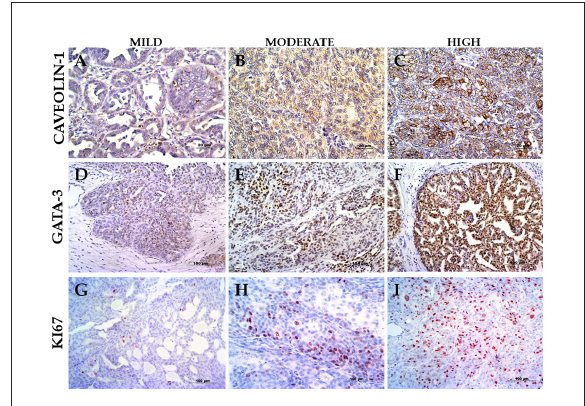
FIGURE1 Immunostaining panel. (A) UC papillary and infiltrating with mild Caveolin-1 (case 6), 400 × magnification. (B) UC papillary and infiltrating with intermediate Caveolin-1 (case 30), 400 × magnification. (C) UC papillary and infiltrating with high Caveolin-1 (case 7), 400 × magnification. (D) UC papillary and infiltrating with mild GATA-3 (case 2), 200 × magnification. (E) UC non-papillary and infiltrating with intermediate GATA-3 (case 22), 200 × magnification. (F) UC papillary and infiltrating with high GATA-3 (case 30), 200 × magnification. (G) UC papillary and infiltrating with mild Ki67 (case 15), 200 × magnification. (H) UC papillary and infiltrating with intermediate Ki67 (case 26), 200 × magnification. (I) UC non-papillary and infiltrating with high Ki67 (case 14), 200 × magnification.